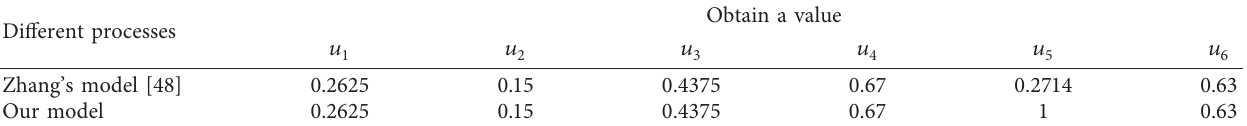
Table 17: Values by FCITFRS.